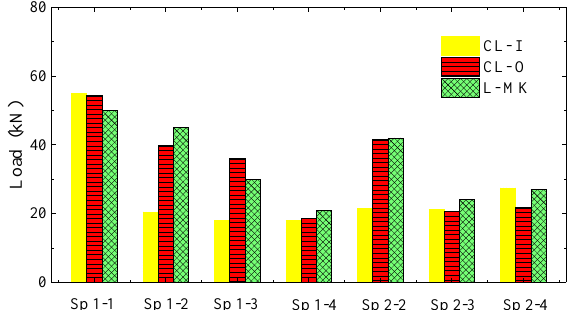
Figure 14. Loads defined by the MK method.